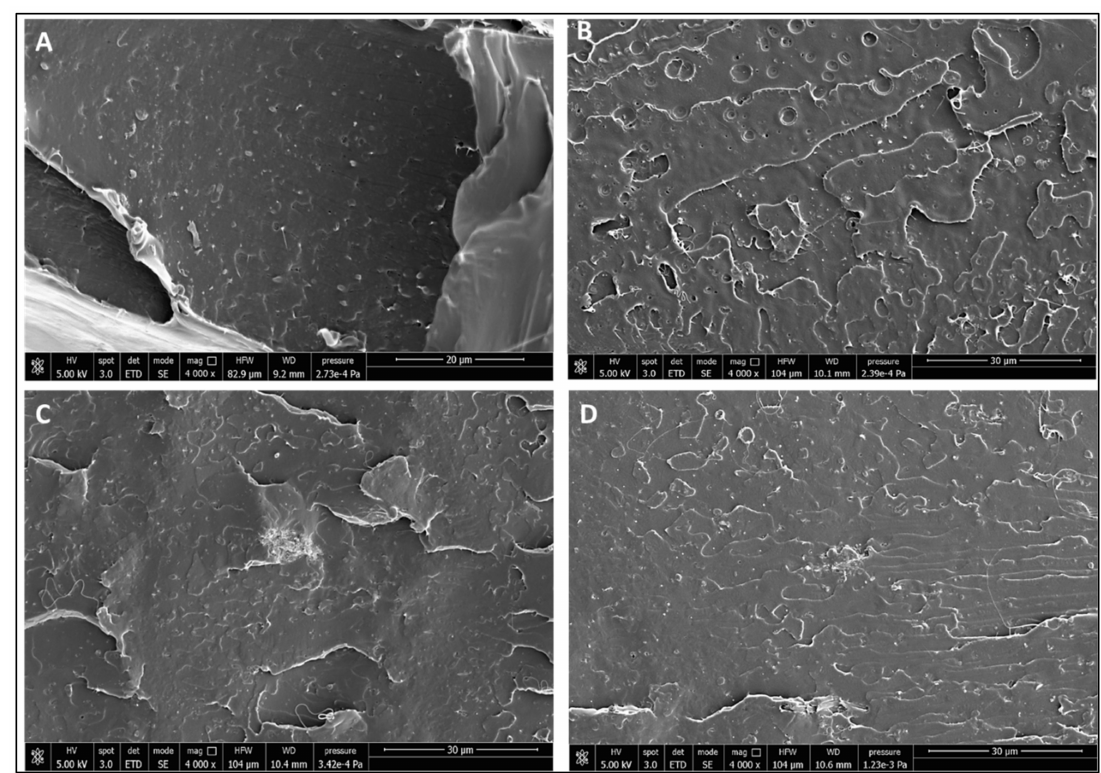
Figure 6. SEM micrographs of PLA_PEG_5_EX ( A ), PLA_OLA_5_CE ( B ), PLA_PEG_5_EX ( C ), and PLA_OLA_5_CE ( D ) at a magnification of 4000 × .